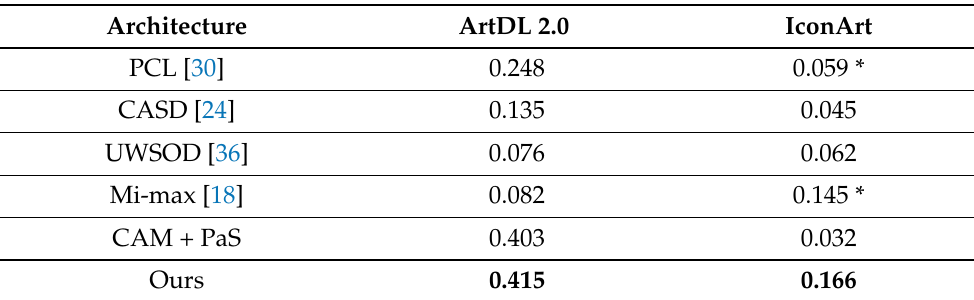
Table 7. WSOD Performance —Detection capabilities are evaluated on the test set using the Pascal VOC mAP metric. The results marked with * are taken from the original works. The best-performing architecture for each data set is highlighted in bold.